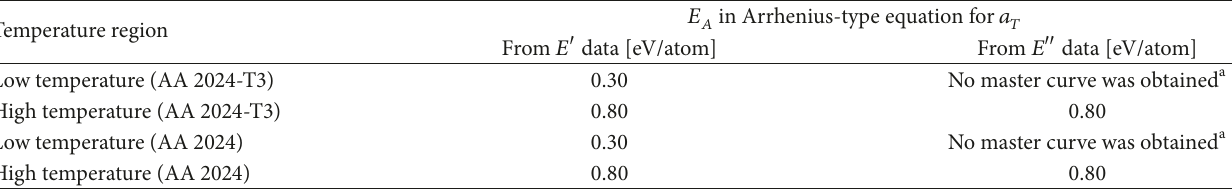
Table 4: Activation energy 𝐸 𝐴 in the Arrhenius-type equation for the shift factor 𝑎 𝑇 for Al–Cu–Mg alloys. Temperature